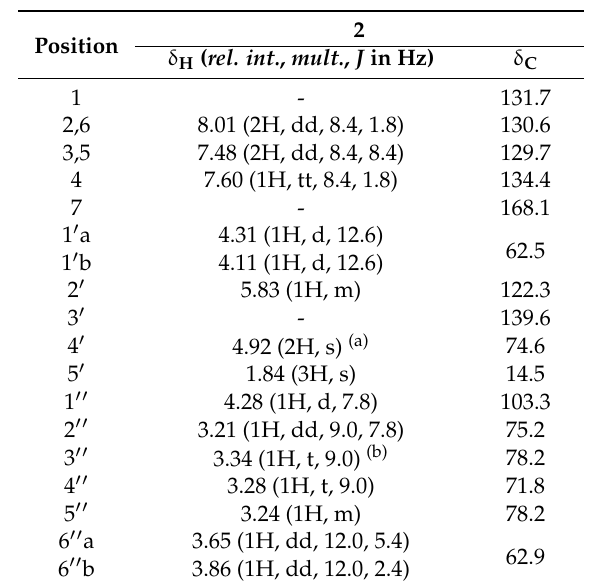
(Figure 5, bold lines), HSQC, and HMBC (Figure 5, arrows) experiments. In particular, correlation from H-1 1 to C-7 1 observed in the HMBC spectrum indicated that 2-methylbut-2-ene-1,4-diol was esterified with benzoic acid (Figure 5, arrows). Correlations from H-1 11 to C-4 1 and H-4 1 to C-1 11 observed in the HMBC spectrum indicated that glucose moiety was etherified with the 4 position of 2-methylbut-2-ene-1,4-diol (Figure 5, arrows). Consequently, the structure of 2 was unambiguously determined to be 4 1 - O - β - D -glucopyranoyl ( E )-4-hydroxy-3-methylbut-2-enyl benzoate (Figure 5), which is a new compound. Table 1. 1 H- and 13 C-NMR data of 2 in methanol- d 4